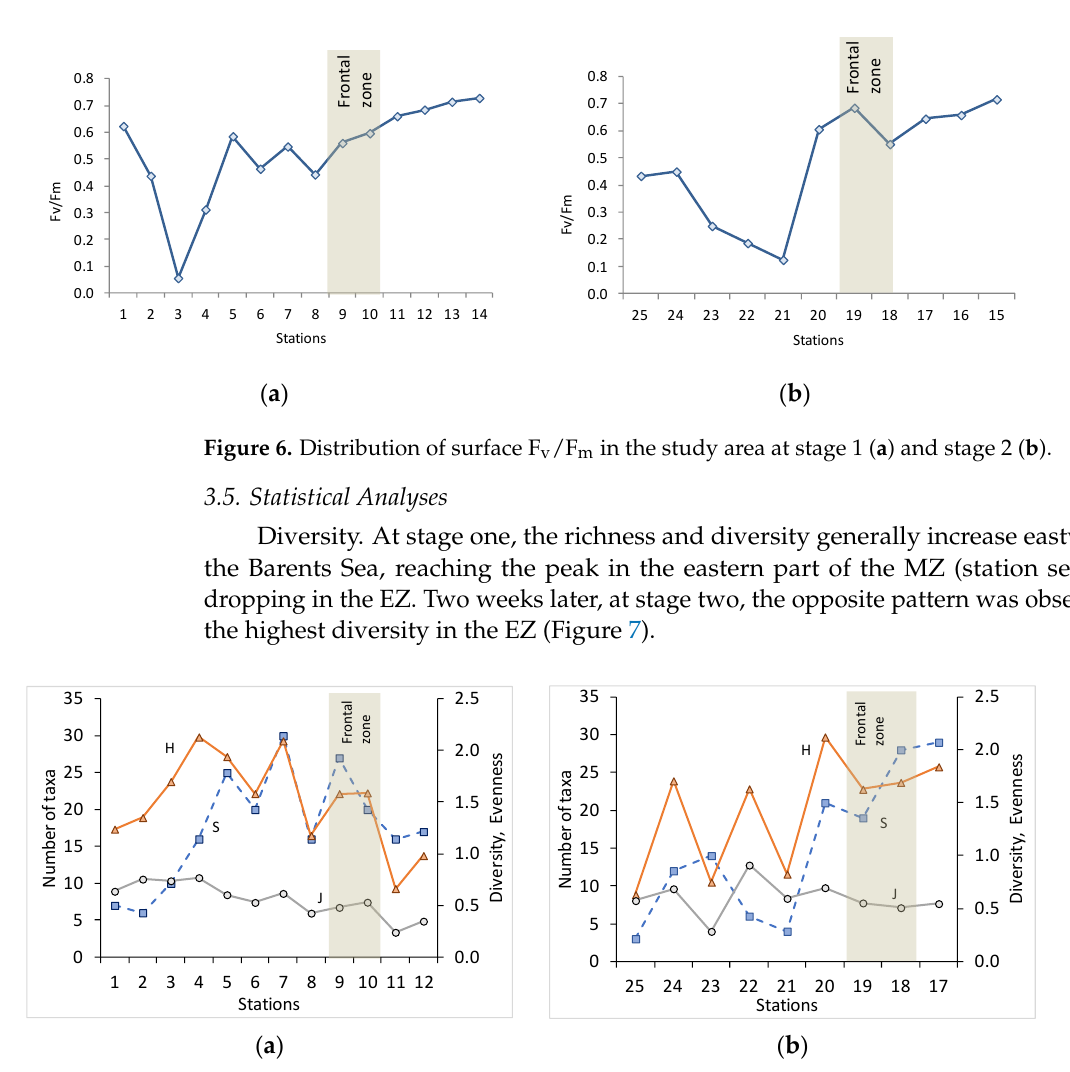
Figure 7. Distribution of number of taxa (S), diversity (H), and evenness (J) in the study area at stage 1 ( a ) and stage 2 ( b ). Community composition. The n MDS ordination by community composition of sev- eral “marine” stations (stations 1–3 and 21–25) were clearly separated from others located close to the Ob River discharge zone (Figure 8). The significance of the difference between these two groups was confirmed by the one-way ANOSIM test (R = 0.663; p <0.001). Plank- ton of the first group of stations was characterized by a relatively high contribution of flagellates, mainly dinoflagellates Gyrodinium lacryma , Gymnodinium sp ., and Protoperi- dinium pallidum (on average up to 40% of the total biomass), and an unidentified group of small phototrophic microalgae (26%) and cryptophytic algae Teleaulax amphioxeia (10%), while the diatoms ( Thalassiosira spp ., Pauliella taeniata , Melosira varians, and Fossulaphycus arcticus ) constituted up to 70% of the biomass at the stations of the second group. Three abiotic variables (salinity, silicate, and nitrite concentrations) had the highest correlations with the biotic ordination positions (Figure 8), marking the separation be- tween these two groups of stations (all the correlation coefficients > 0.7, p < 0.01). The four stations from the frontal zone (stations 9, 10, 18, and 19) were situated close together, in- dicating high similarity in their phytoplankton composition.